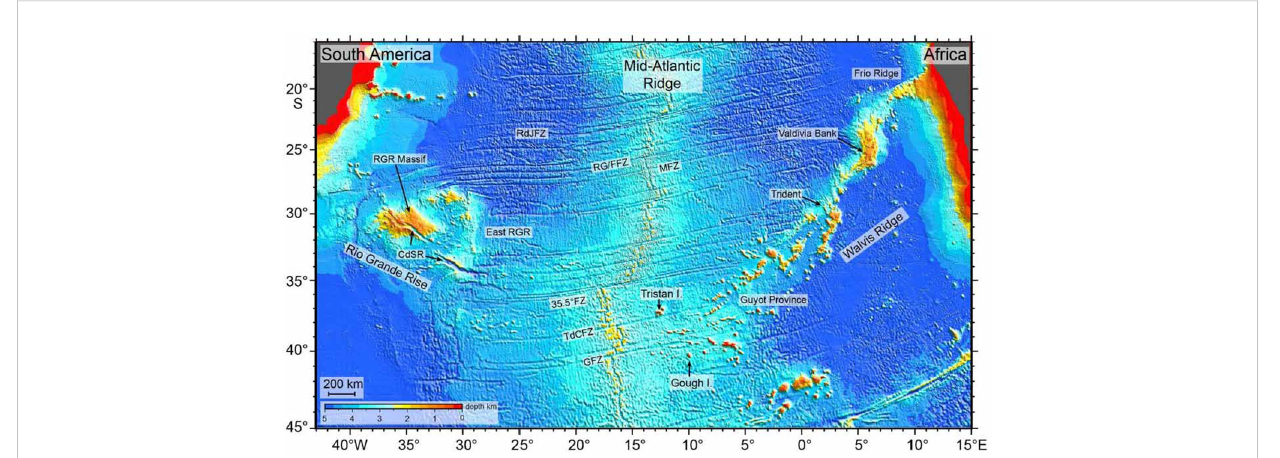
FIGURE 2 Bathymetric map of SAO, including the RGR, Walvis Ridge, Tristan da Cunha mantellic plume and smaller features. The bathymetry was a product between available depth soundings and high-resolution marine gravity information from the Geosat and ERS-1 spacecraft (Smith and Sandwell, 1997). Extracted from Sager et al., 2021. RdJFZ, Rio de Janeiro Fracture Zone; RG/FFZ, Rio Grande – Florianopolis Fracture Zone; MFZ, Moore Fracture Zone; TdCFZ, Tristan da Cunha Fracture Zone; GFZ, Gough Fracture Zone; CdSR, Cruzeiro do Sul